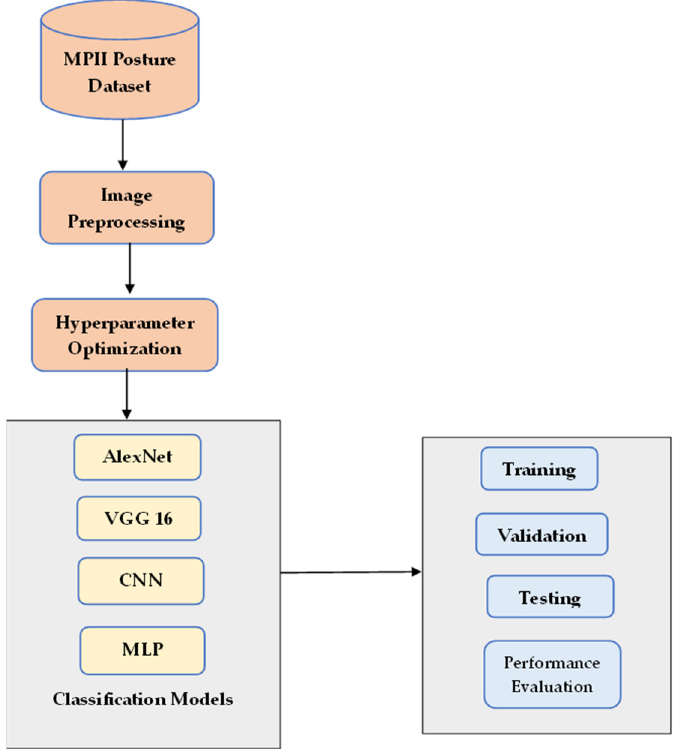
Figure 6. Proposed decision support models’ hyperparameter-optimizer architecture.